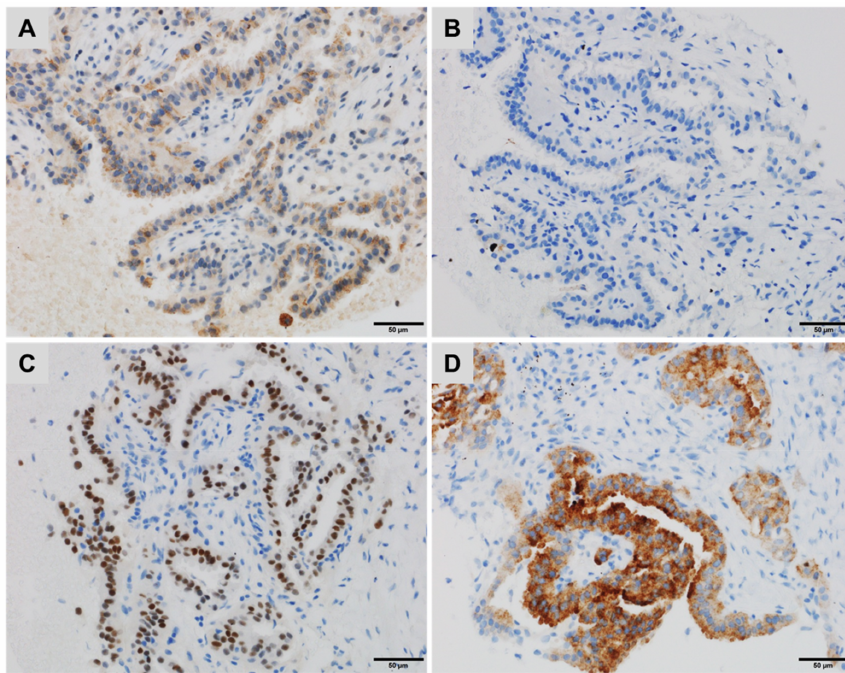
Figure 1. A lung metastasis of a thyroid carcinoma with a micropapillary component showing ( A ) cytoplasmic staining for Napsin A, ( B ) negative staining for Thyroglobulin, ( C ) diffuse, strong nuclear staining for PAX8 and ( D ) strong cytoplasmic staining for BRAFV600E (immunoperoxidase, clone